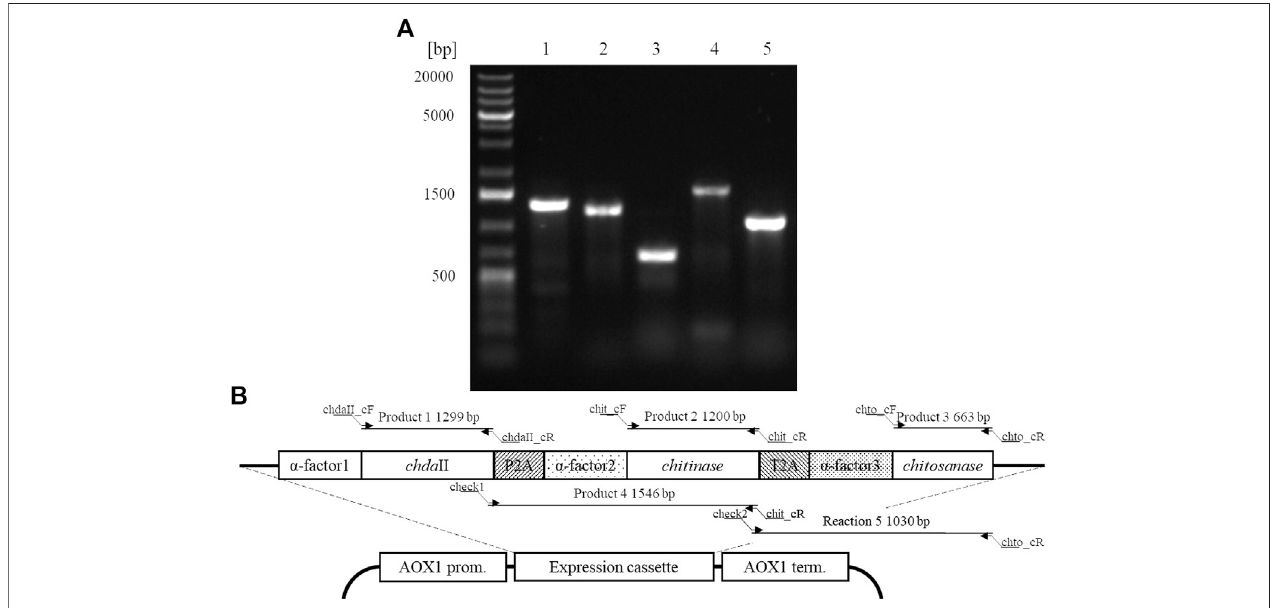
FIGURE5| A.ElectrophoreticanalysisofproductsobtainedbyColonyPCRanalysis( SupplementaryTableS3 )carriedoutforaselectedtransformant P.pastoris KM71H_pCHIT. Map of the expression cassette of the polycistronic vector pCHIT with marked sizes of products obtained as a result of PCR colony